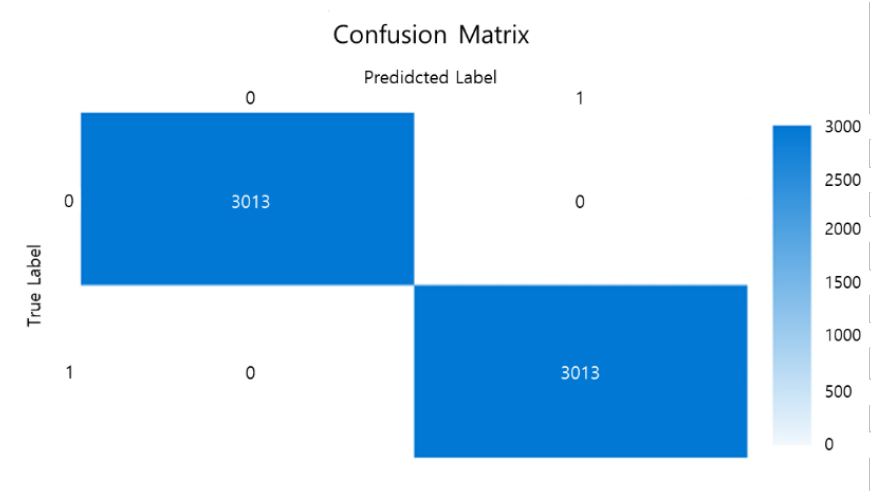
Figure 9. MinMaxScalerRandomForest confusion matrix.